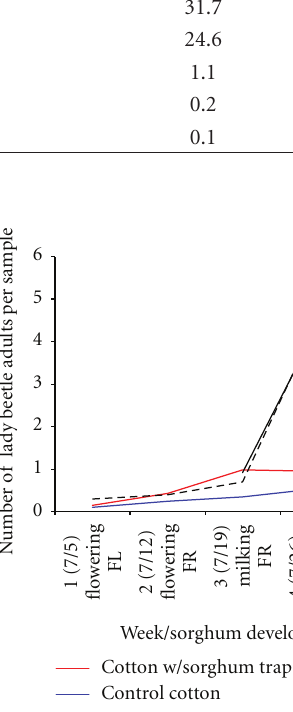
Figure 1: Mean number of lady beetle adults per sample in cotton with a sorghum trap crop, control cotton, sorghum, and yellow pyramidal traps in 2006. FL: flowers; FR: fruit. Number of lady beetles in yellow pyramidal traps divided by 10. Date refers to middle of sampling